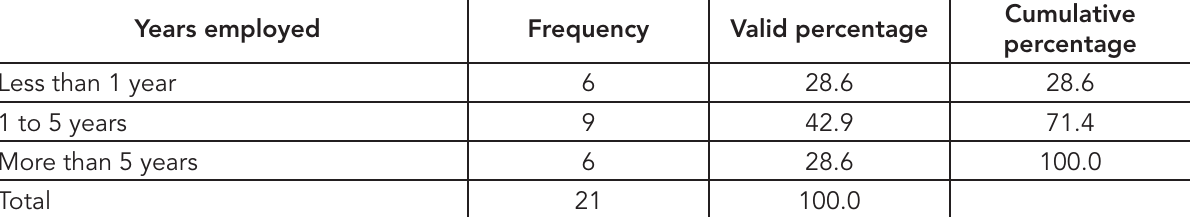
Table 2: Number of years employed at